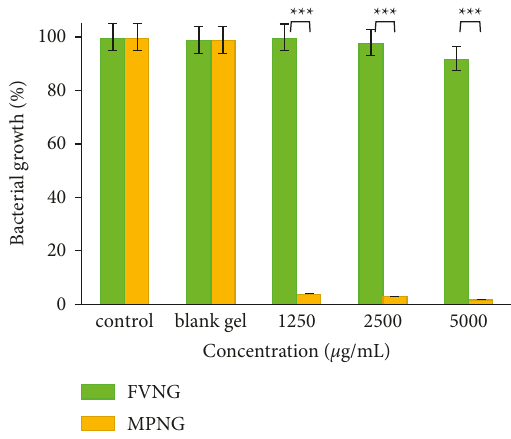
Figure 6: Antibacterial effects of nanogels containing F. vulgare and M. piperita EOs (FVNG and MPNG) and their blank gels (without EO) against E. coli . The efficacy of MPNG was more P potent ( 0 . 001) than FVNG. ∗∗∗ <